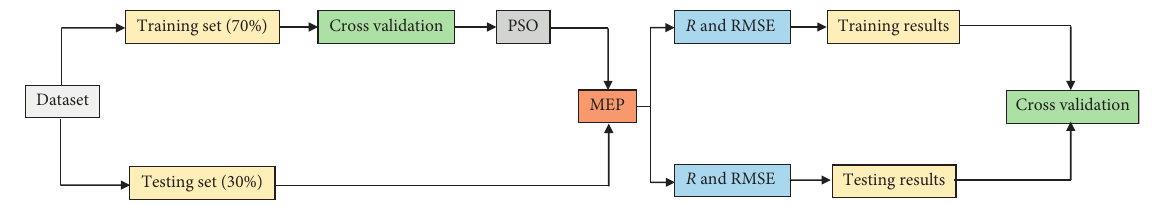
Figure 2: Hyperparameter tuning by PSO. Table 3: XRF results of